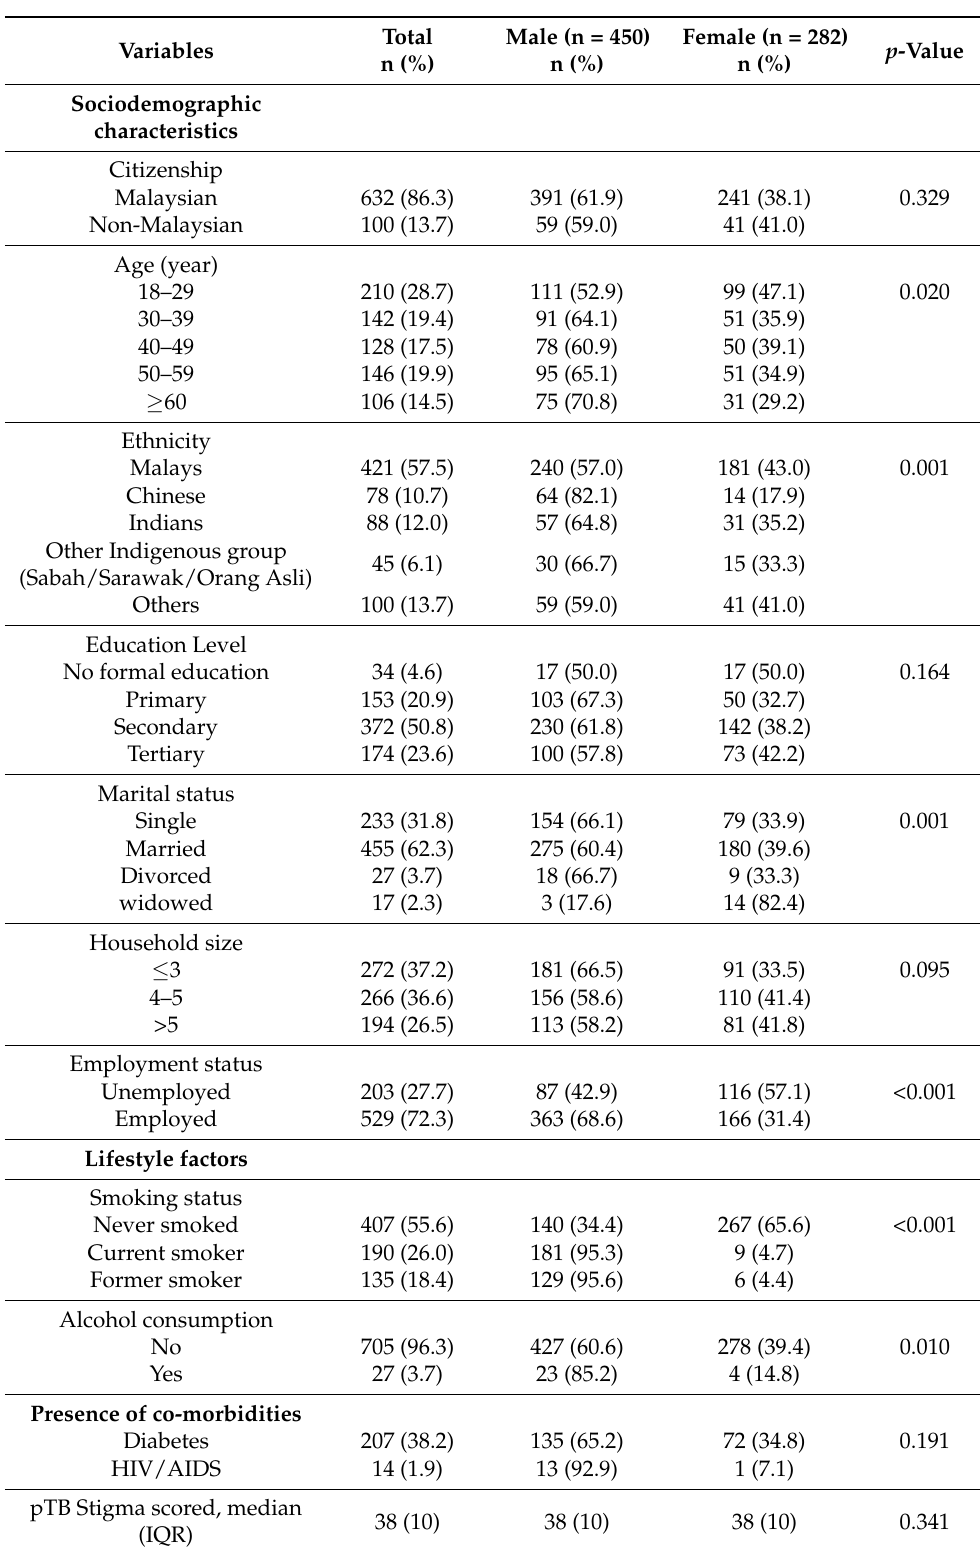
Table 1. Sociodemographic characteristics, lifestyle, co-morbidities, clinical presentation, knowledge about pulmonary tuberculosis, stigma, and healthcare-seeking behavior of the patients stratified by gender (n =